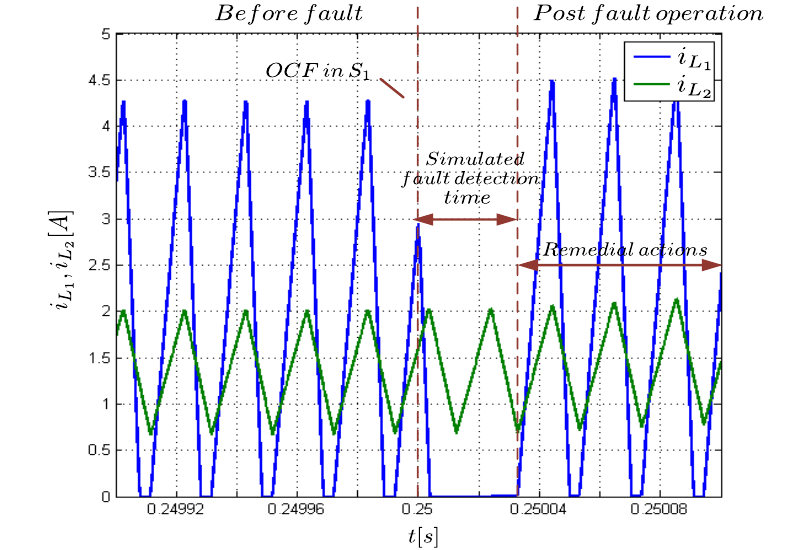
Figure 16. OCF in S 1 at t = 0.25 s: currents flowing through the inductors L 1 and L 2